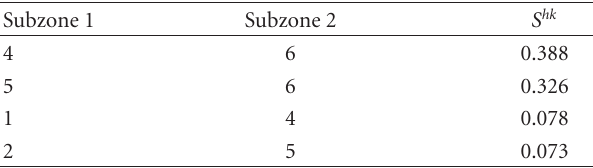
Table 3: Similarity index between adjacent subzones.